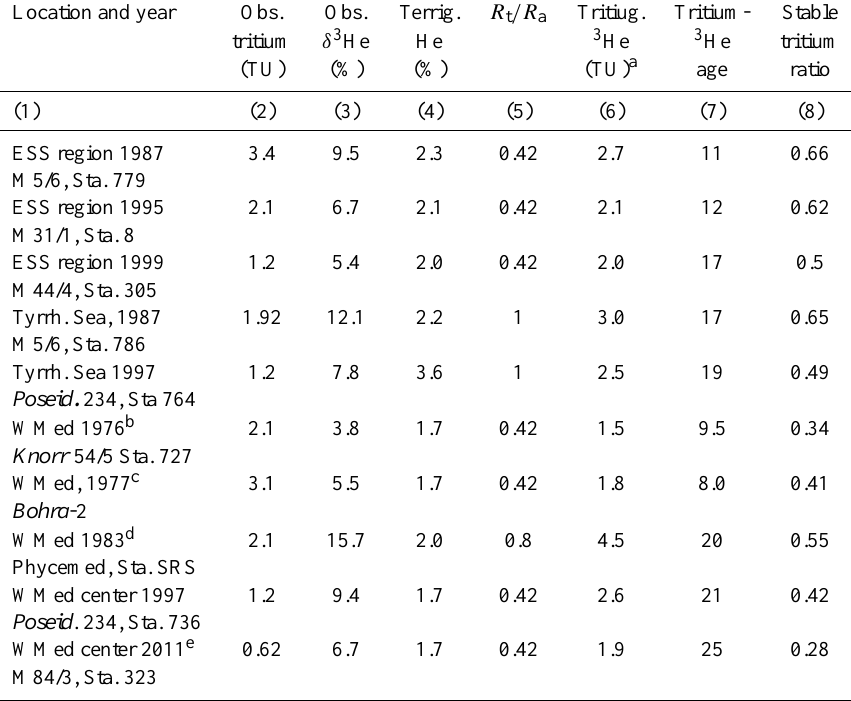
Table 3. Tritium- 3 He ages (yr) in LIW at various locations in different years. The tritium and δ 3 He values are averaged over the LIW layer. For the EES region, just upstream of Sicily Strait, values between about 200 and 600m are used to include the CIW, further west the range is about 400 to 600m. For the stable tritium ratio, see text. The initial tritium values are given by the sum of the (2) and (6) values, divided by (8). Location and year Obs. Obs. Terrig.